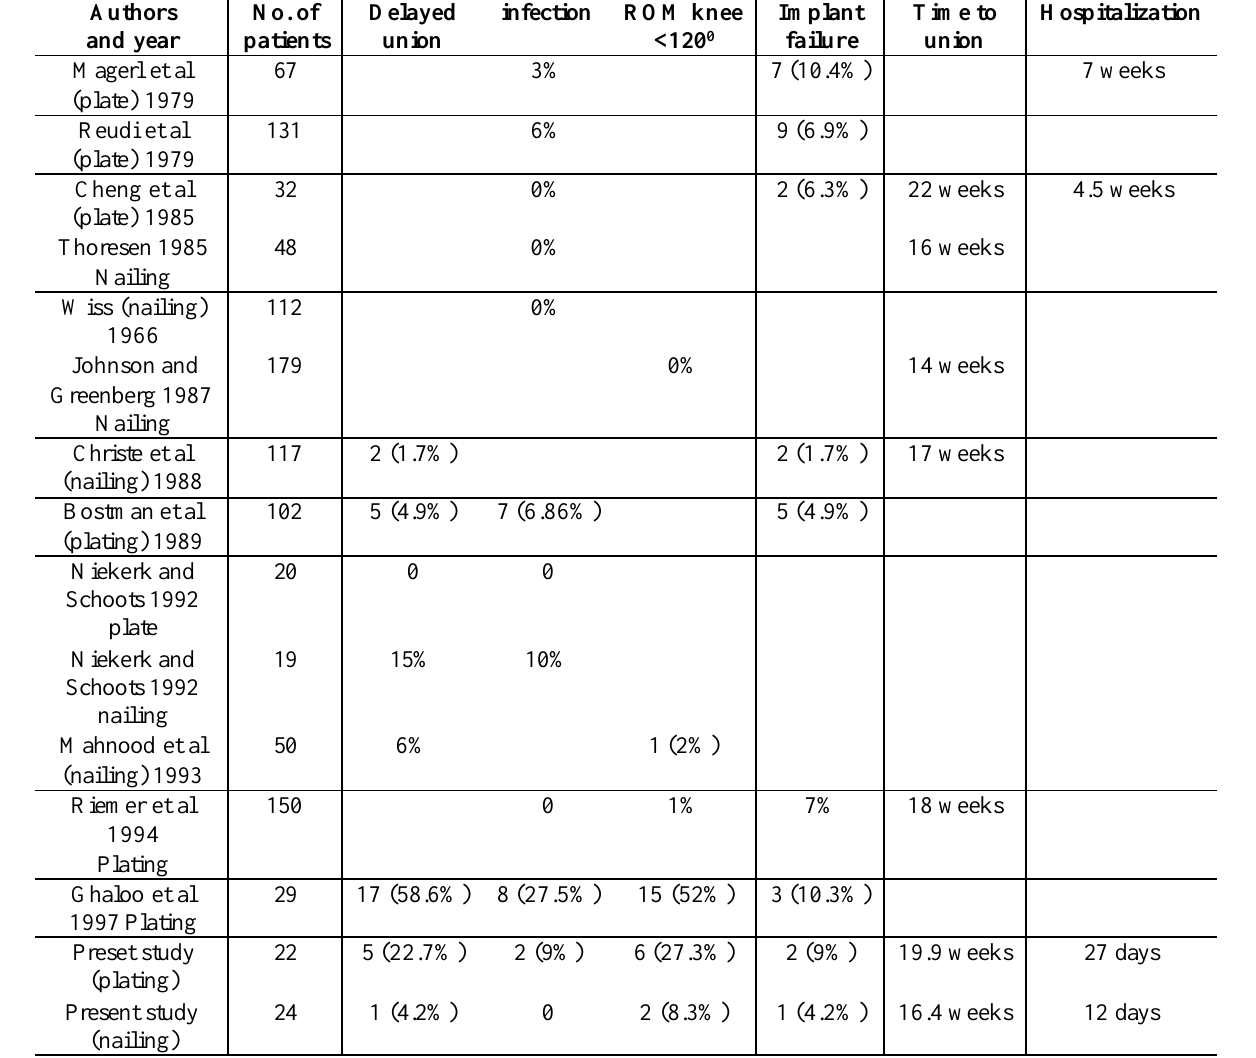
Table V : Comparison of treatments of femoral shaft fracture : Closed nailing and plating with present study